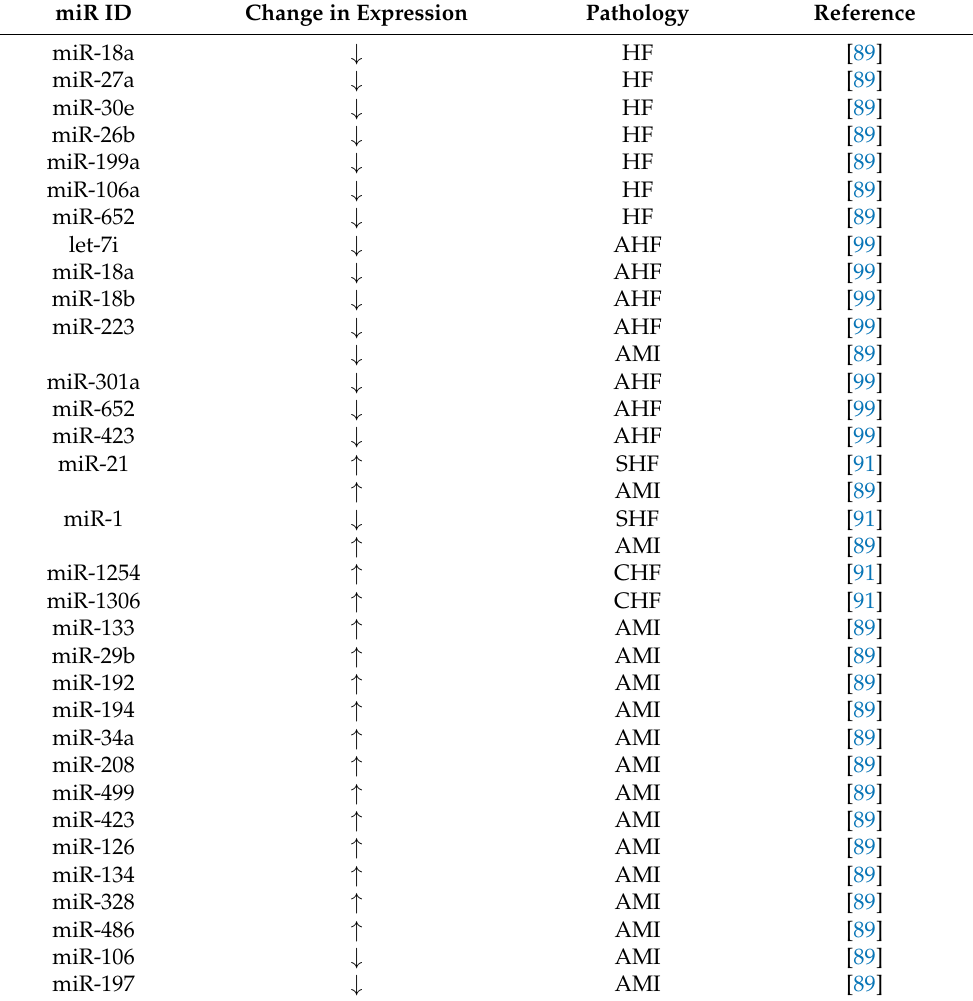
Table 1. MicroRNA (miR) in ischemic heart disease. miR ID Change in